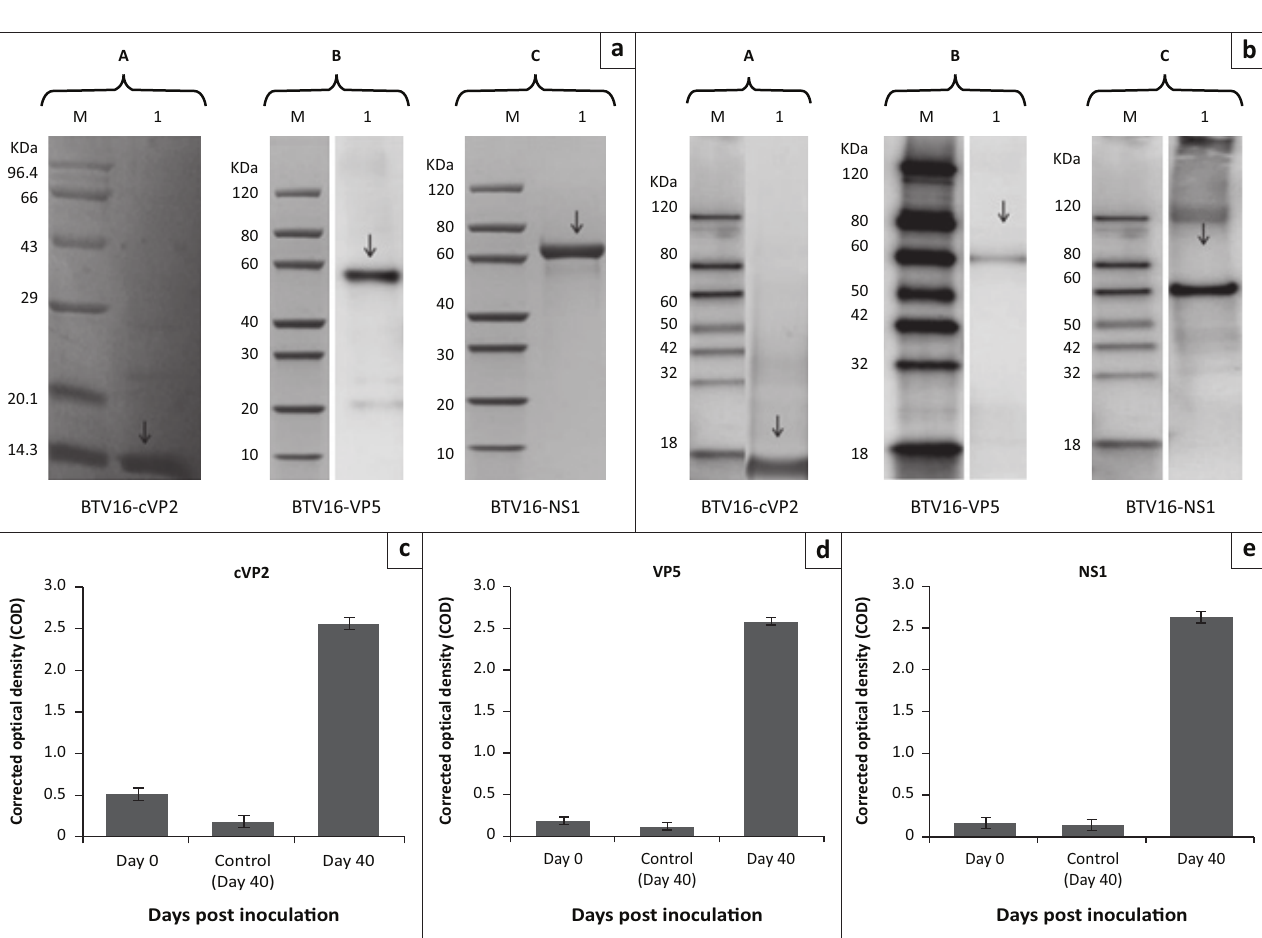
BTV, bluetongue virus; COD; corrected optical density; cVP2, conserved region of VP2; ELISA, enzyme-linked immunosorbent assay; OD, optical density; SDS-PAGE, sodium dodecyl sulfate- polyacrylamide gel electrophoresis. FIGURE 1: Identification of purified BTV recombinant proteins and detection of protein-specific antibodies by indirect ELISA. (a) Ni-NTA purification of recombinant BTV proteins, and SDS-PAGE analysis of purified cVP2, VP5 and NS1: arrowheads indicate recombinant BTV proteins at the expected molecular weights. A (Lane 1): cVP2, 9.35 KDa; B (Lane 1): VP5, 59.8 KDa; C (Lane 1): NS1, 61.2 KDa. Lane M: protein marker. (b) Western blot confirmation of tagged proteins: His-tagged recombinant BTV proteins were detected using anti-His antibodies. Lane M: protein marker; A (Lane 1): cVP2, 9.35 KDa; B (Lane 1): VP5, 59.8 KDa; C (Lane 1): NS1, 61.2 KDa. (c, d, e) Protein-specific antibodies against BTV cVP2, VP5 and NS1 in immunised mice. Mice were vaccinated thrice with a 2-week interval using BTV recombinant proteins (Table 1). The COD values were calculated as (COD = OD Sample – OD background) and compared with preimmunised and control group. values. TABLE 2: Serum neutralisation test antibody titres expressed as log 10 Group